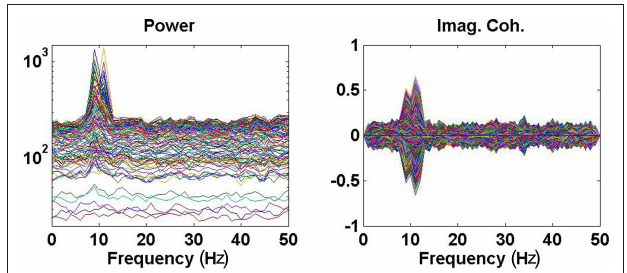
FIGurE 2 | Left: Power over all channels. Right: Imaginary part of coherency over all pairs of channels.